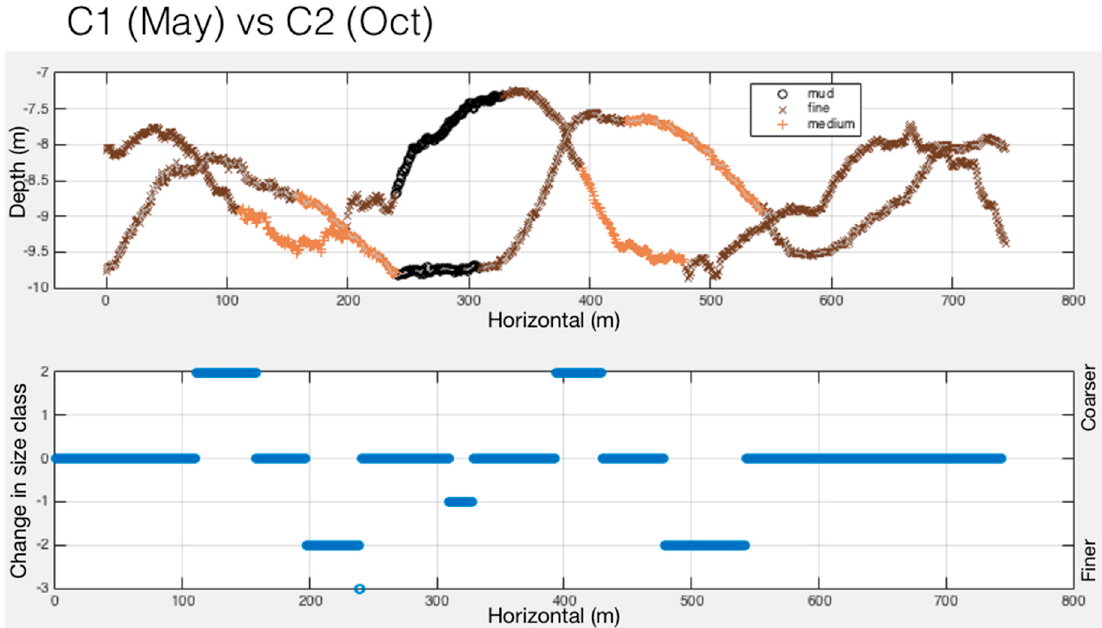
Figure 21. Bathymetry profile change versus sediment class boundary shift after Hurricane Joaquin, Assateague Island National Seashore. Curved bathymetry profiles C1 (May 2015) and C2 (October 2015) in Figure 25 are color coded according to the sediment types in the chart located in the top. Horizontal scale are meters in both panels, and vertical are meters in the top panel and size class index in the bottom panel. Sediment classes were indexed from 1 to 4, 1 representing the finest and 4 representing the coarsest. The chart in the bottom was generated by subtracting sediment type values of C1 (May 2015) from C2 (October 2015) to understand if the seafloor sediments are coarsening or fining with the lateral shift in bathymetry. Please note the coarsening of sediments in the top of the sand bars and fining of sediments in the trough. Inset scale is in meters on both axes.